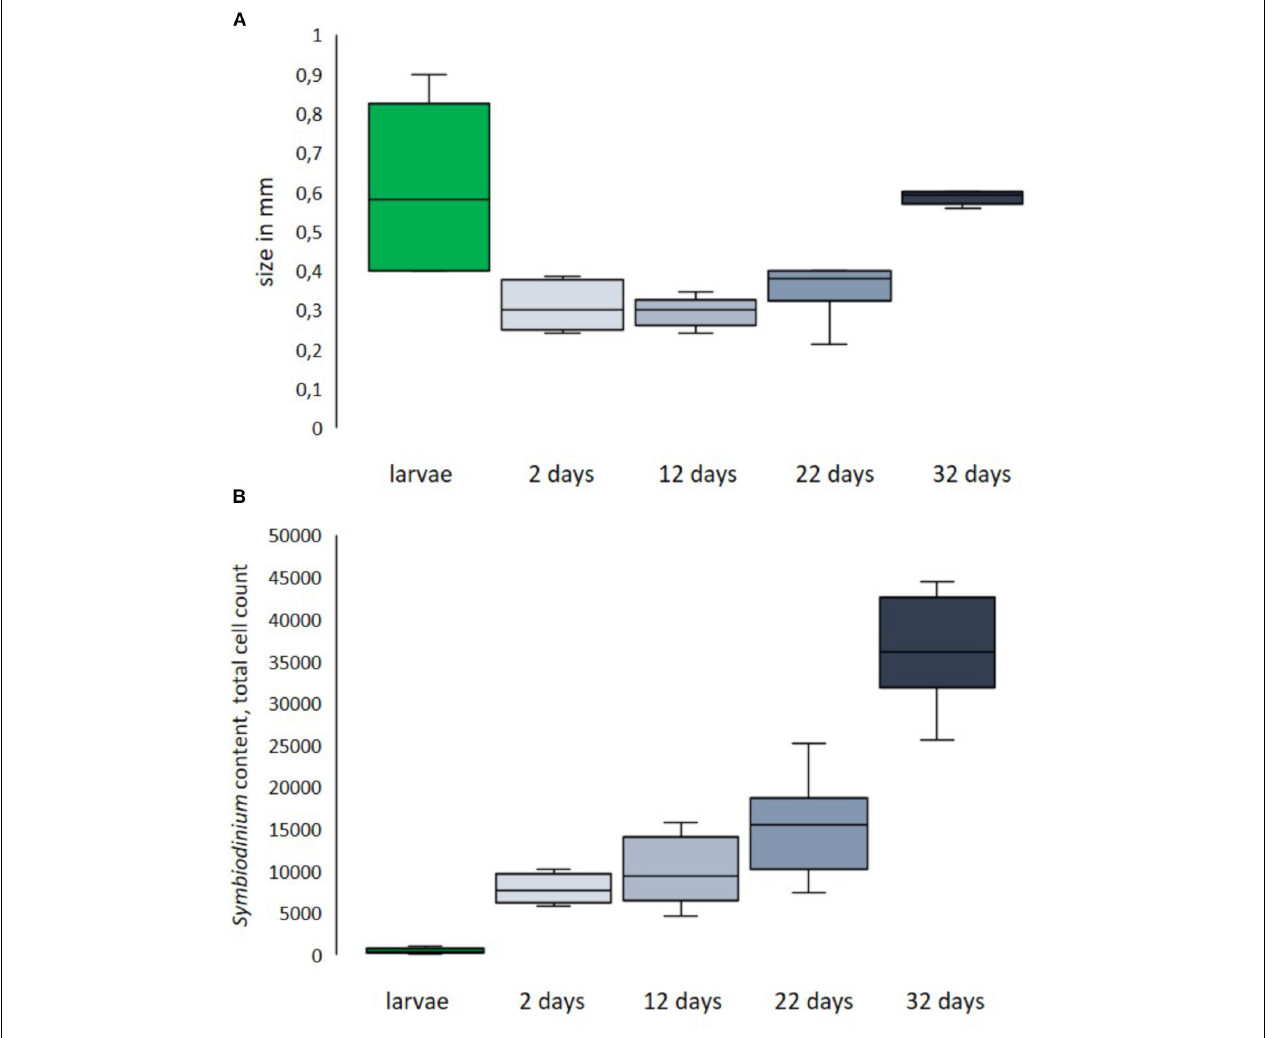
FIGURE 7 | Size distribution (A) and symbiont content (B) of fresh larvae and primary polyps of different ages post-settlement. Size of larvae is length, size of recruits is corallite